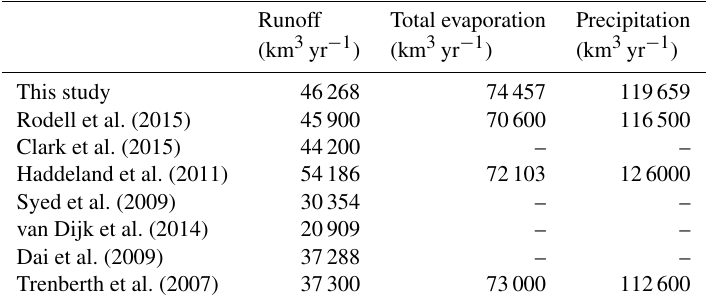
Table 8. Comparison of mean annual total of terrestrial precipitation, evapotranspiration and runoff with previous